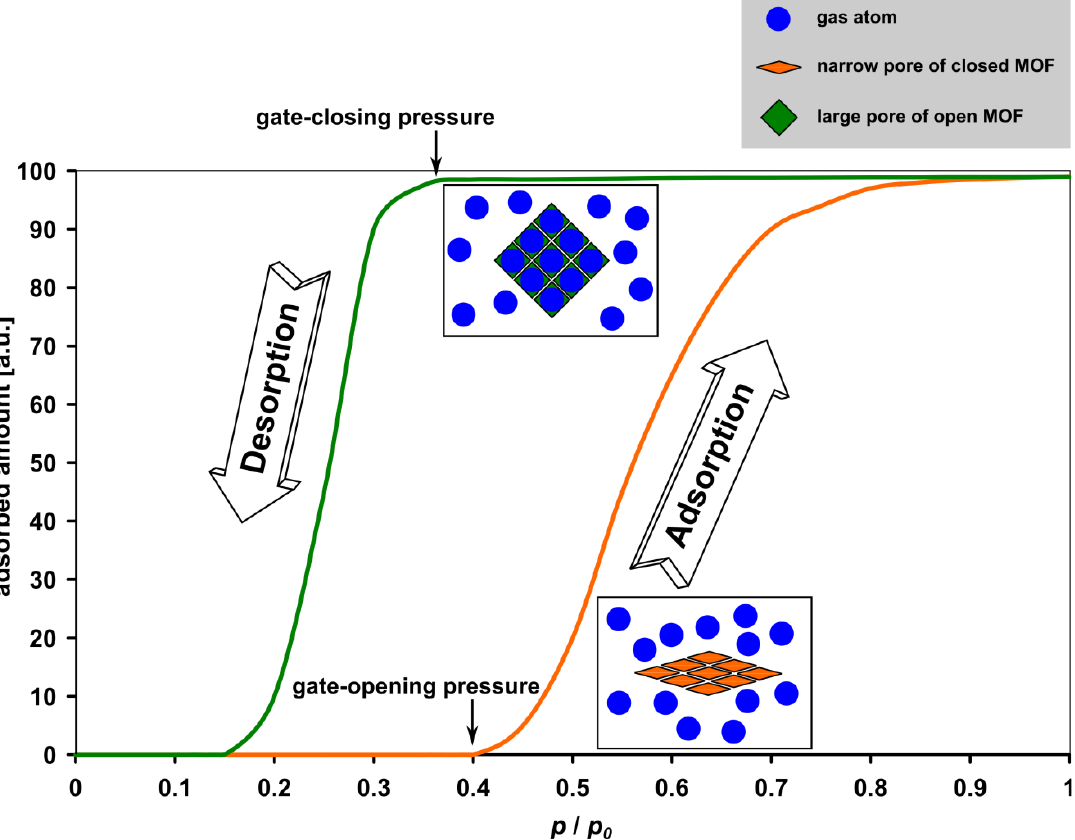
Figure 2. Schematic demonstrating the gate-pressure effect for isothermal